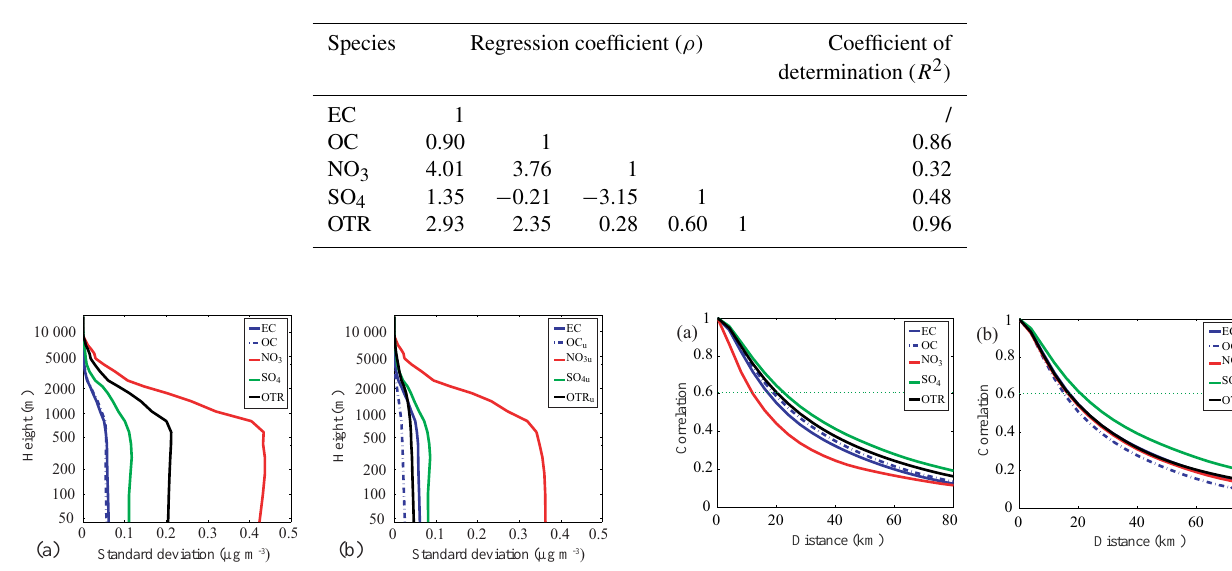
Figure 4. Vertical profiles of the standard deviation of the variables. (a) Full variables and (b) unbalanced variables. portion is an unbalanced component. In contrast with NO 3 , a small portion of OTR is the unbalanced component.